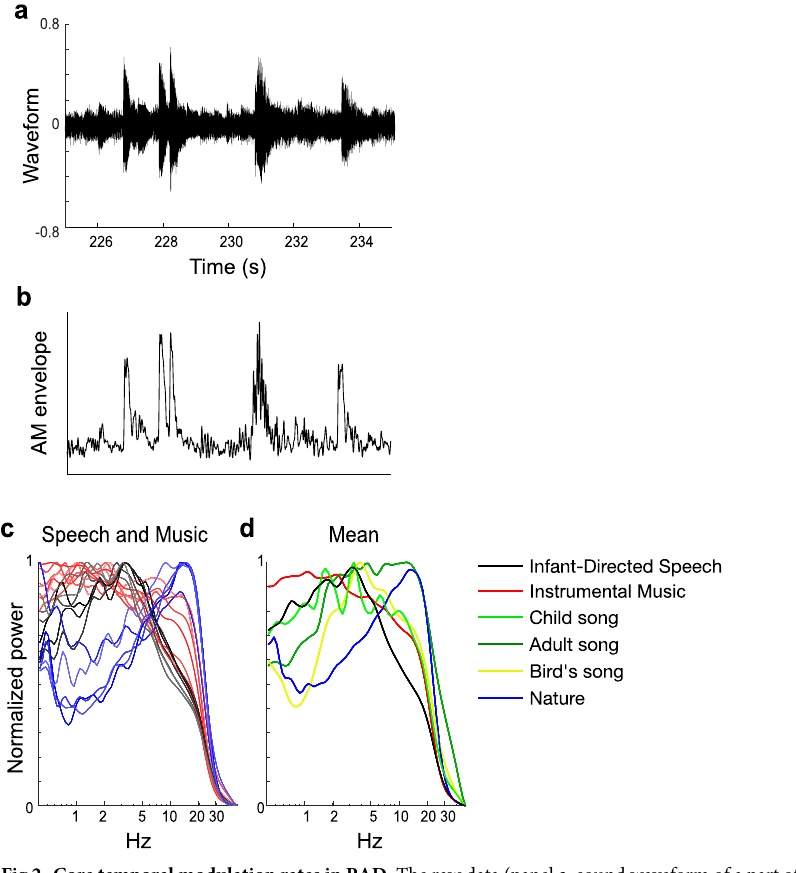
Fig 2. Core temporal modulation rates in PAD. The raw data (panel a, sound waveform of a part of the 33 Variations on a waltz by Anton Diabelli, Op. 120 by Ludwig van Beethoven) are demodulated using PAD to yield an AM envelope, shown in panel b . Individual lines in panels c represent different speakers, musical genres, and nature sounds. Panel c shows the similar acoustic statistical properties of IDS and Music: for example, hierarchical peaks in lower frequencies (~5Hz) for IDS and music, but not for nature sounds. The average of the normalized power of scalograms of Continuous Wavelet Transforms of the AM envelopes across infant-directed speech (IDS, black lines), music (red lines), nature sounds (blue lines), birdsong (yellow lines), child song (light green), and adult song (thick green) are shown in panel d . Panel d shows 2Hz and 5Hz peaks in both IDS and child song, but not in adult song, bird song, and nature